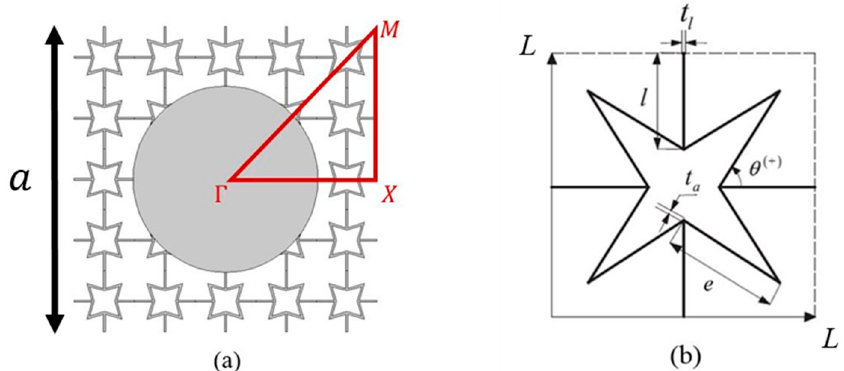
Figure 3. The scheme of the auxetic phononic crystals. ( a ) The unit cell of the phononic crystals composed of star-shaped honeycomb structure and circular shaped inclusion; ( b ) the unit cell structure of the star-shaped honeycomb. The parameter of star-shaped honeycomb is 𝑙 = 0.05 m , 𝑒 = 0.05 m , 𝑡 (cid:3039) = 0.005 m and 𝑡 (cid:3028) = 0.005 m . The filling ratio of cylinder are 𝑟 = 0.3𝑎 . Table 1. The effective material properties of steel star-shaped honeycomb, calculated by COMSOL FEM software. [35].